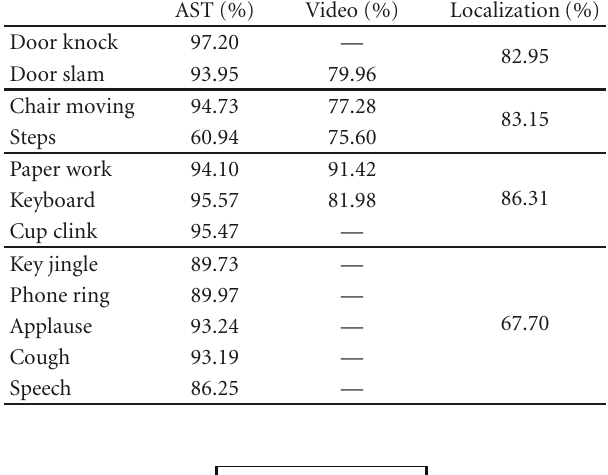
Table 2: Monomodal recognition results.